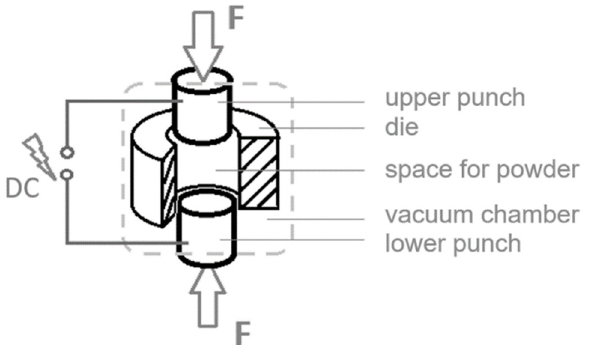
Figure 1. The principal structure of field assisted sintering technique (FAST) systems is a die with two moveable punches, which take the powder inside the resulting cavity. Forced pressure through the punches and temperature caused by electric resistance heating within the packed powder both consolidate the powder into a compact piece. The process set-up is normally placed in a vacuum chamber.